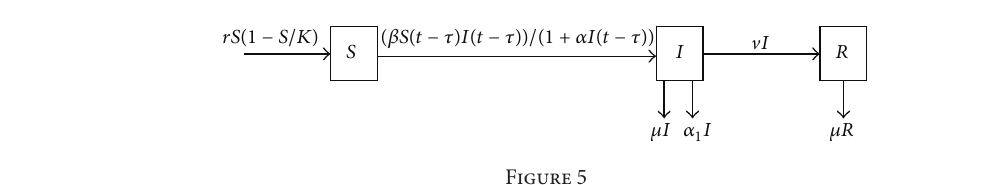
Figure 4: The numerical simulation graphics of 𝑅 0